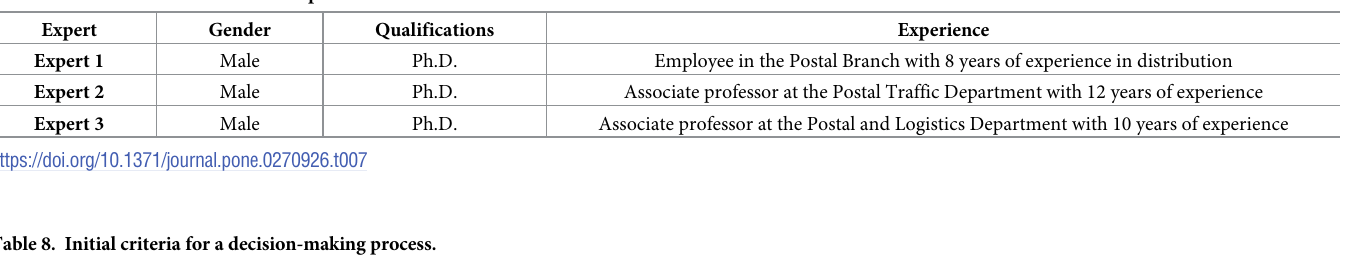
Table 7. The information about the experts.